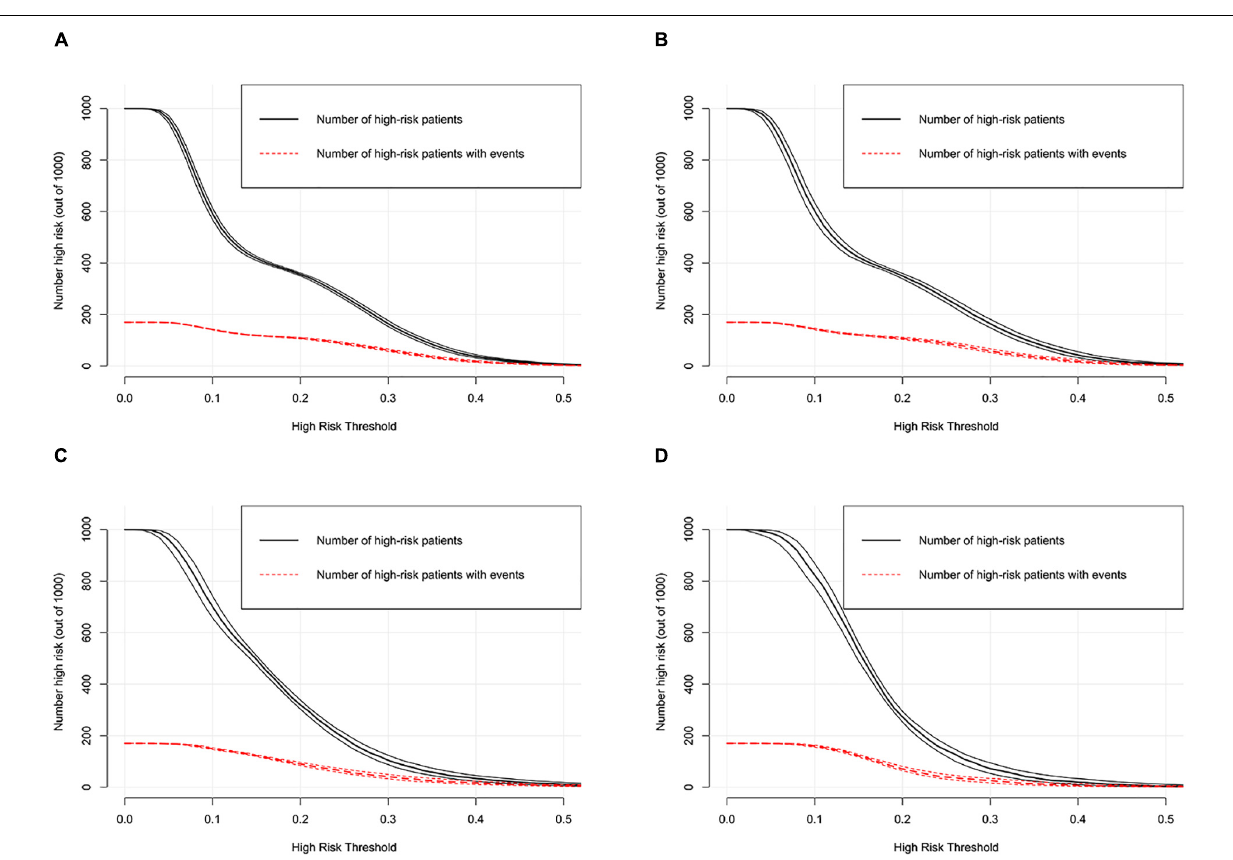
Frontiers in Cardiovascular Medicine |